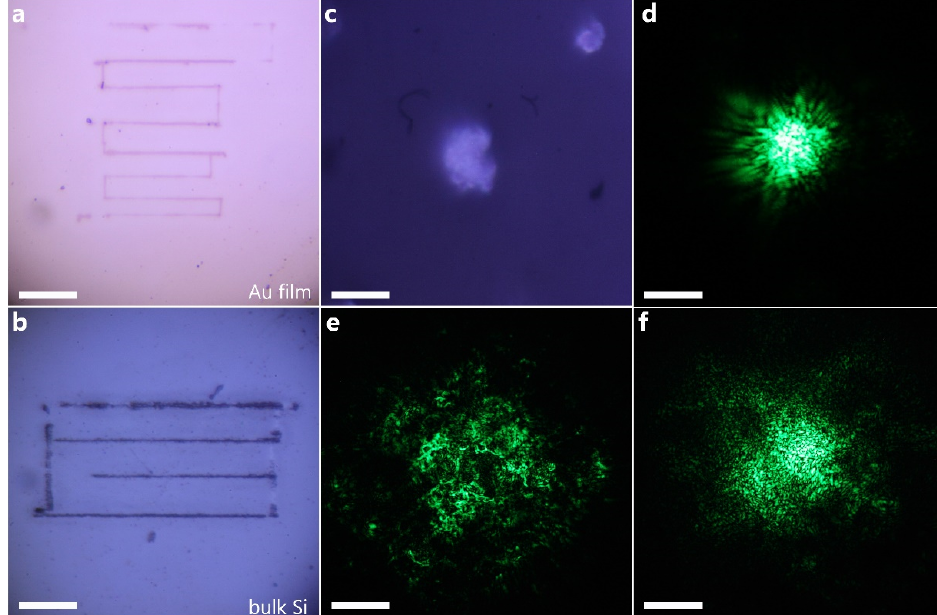
Figure 2. ( a ) Au film (50-nm thick) and ( b ) bulk crystalline silicon substrates damaged by laser radiation (1047 nm central wavelength, 150 fs pulse duration, 10 mW, 1 kHz repetition rate). Scale bars ( a and b ), 50 μ m. Operation at 80 MHz pulse repetition rate results to more dramatic damaging of Au film and silicon. ( c ) Optical image of ZIF-8 powder with corresponding SHG signal ( d ) upon irradiation with an integral power of 100 mW (80 MHz). Scale bars ( c and d ), 20 μ m. ( e , f ) Optical images of SHG for the ZIF-8–PMMA composite with 4 and 12% of ZIF-8. Scale bars ( e and f ), 50 μ m. The optical images of SHG from ZIF-8–PMMA composite at 1 kHz pulse repetition rate are similar to